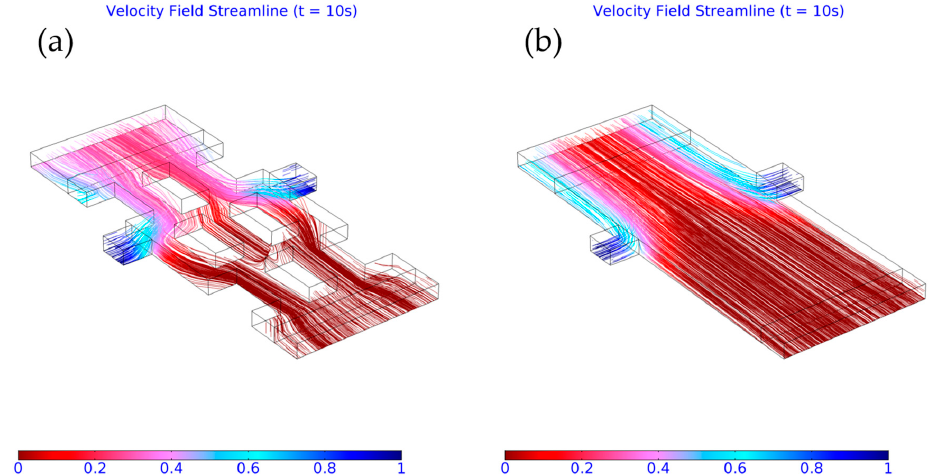
Figure 14. Distributions of mixture volume fractions (between 0 and 1) in mixing chambers: ( a ) with obstacles; and ( b ) without obstacles. The colors represent the volume fractions of the mixture; red corresponds to the blood (volume fraction = 0) and blue corresponds the plasma (volume fraction = 1).